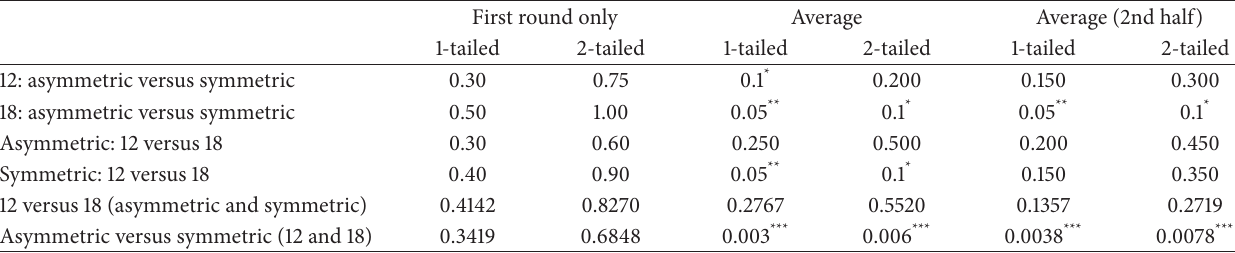
Table 11: Permutation test results ( 𝑝 value)—overall turnout